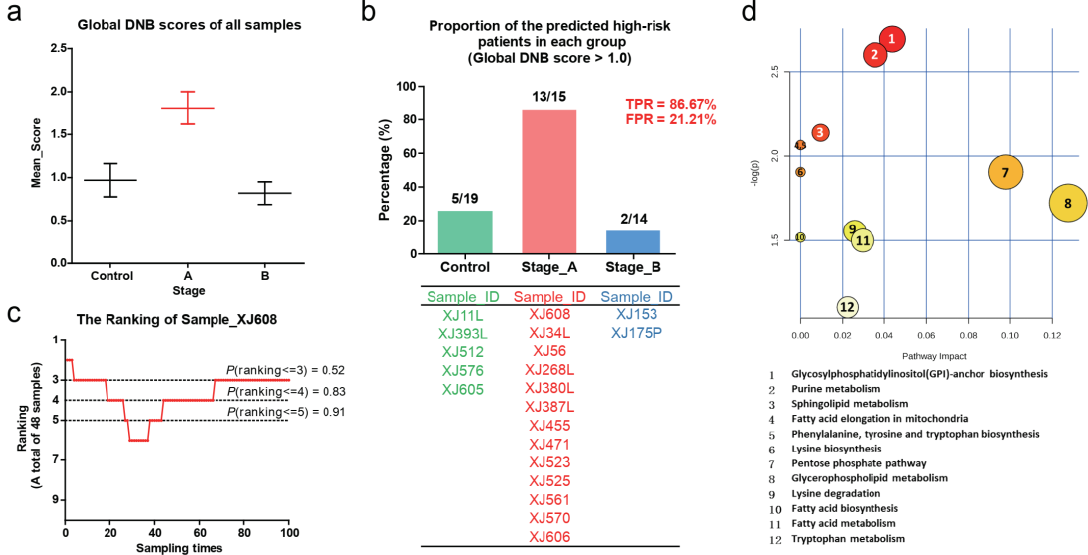
Figure 3. ( a ) The statistical results of the global DNB scores in each group indicated that the tipping point of coronary atherosclerosis is at Stage A. ( b ) The proportion of the predicted high-risk patients (global DNB score > 1.0) in each group (upper panel). Furthermore, the IDs of these patients in each group were listed below. The true positive rate (TPR) is 86.67% and false positive rate (FPR) is 21.21%. ( c ) The ranking of the patient (XJ608) in sampling 100 times. ( d ) The pathway enrichment of DNB molecule candidates. The color is used to distinguish different groups.